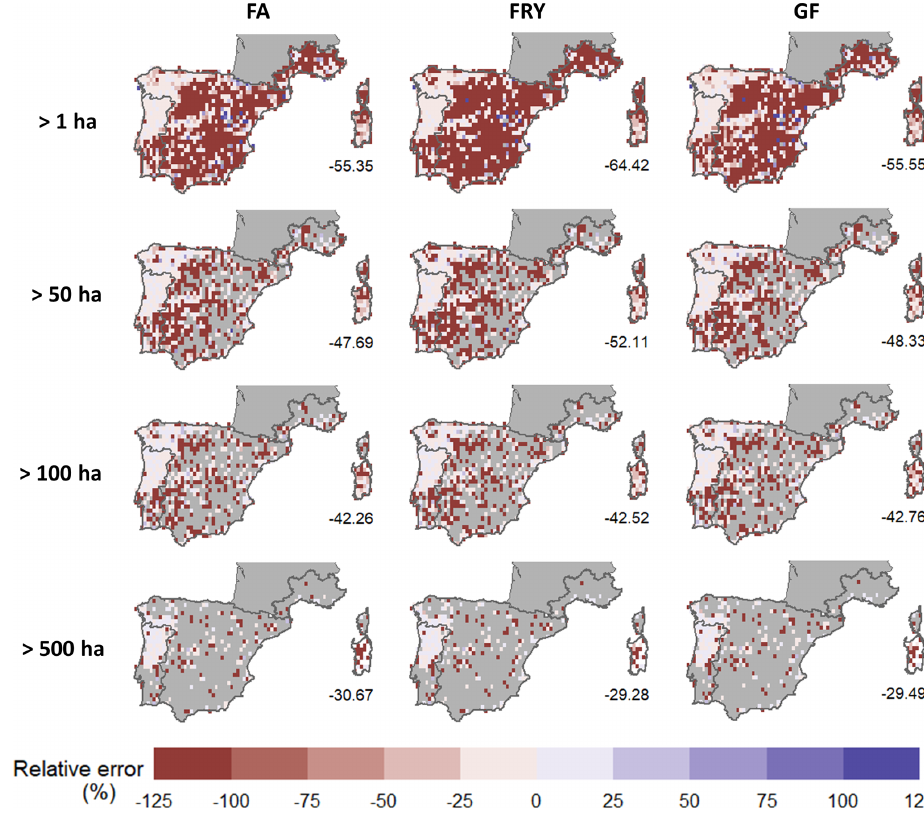
Figure 7. The relative error ( ε ) of the total burned area computed as the relative difference between RSDs and GBD data over different individual fire size thresholds (1, 50, 100, and 500ha). The overall ε is indicated on each